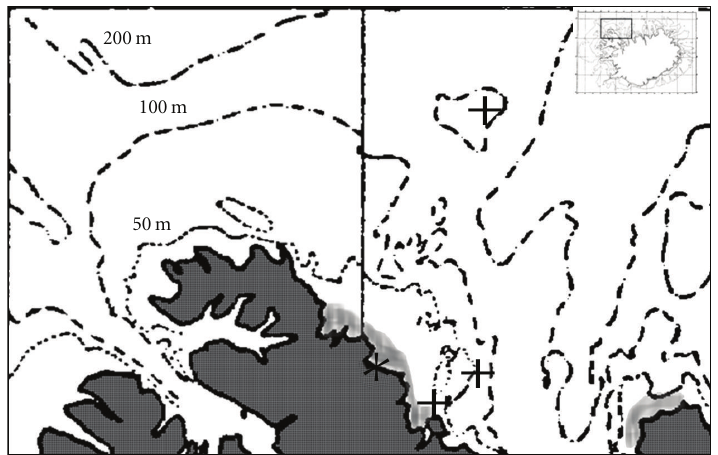
Figure 1: Location of sampling stations (+) for cod ( Gadus morhua ), in relation to the shoreline and the main breeding spot (black ∗ ) of grey seals ( Halichoerus grypus ) in the area, the general breeding distribution in the area is indicated on the figure with a shade of light